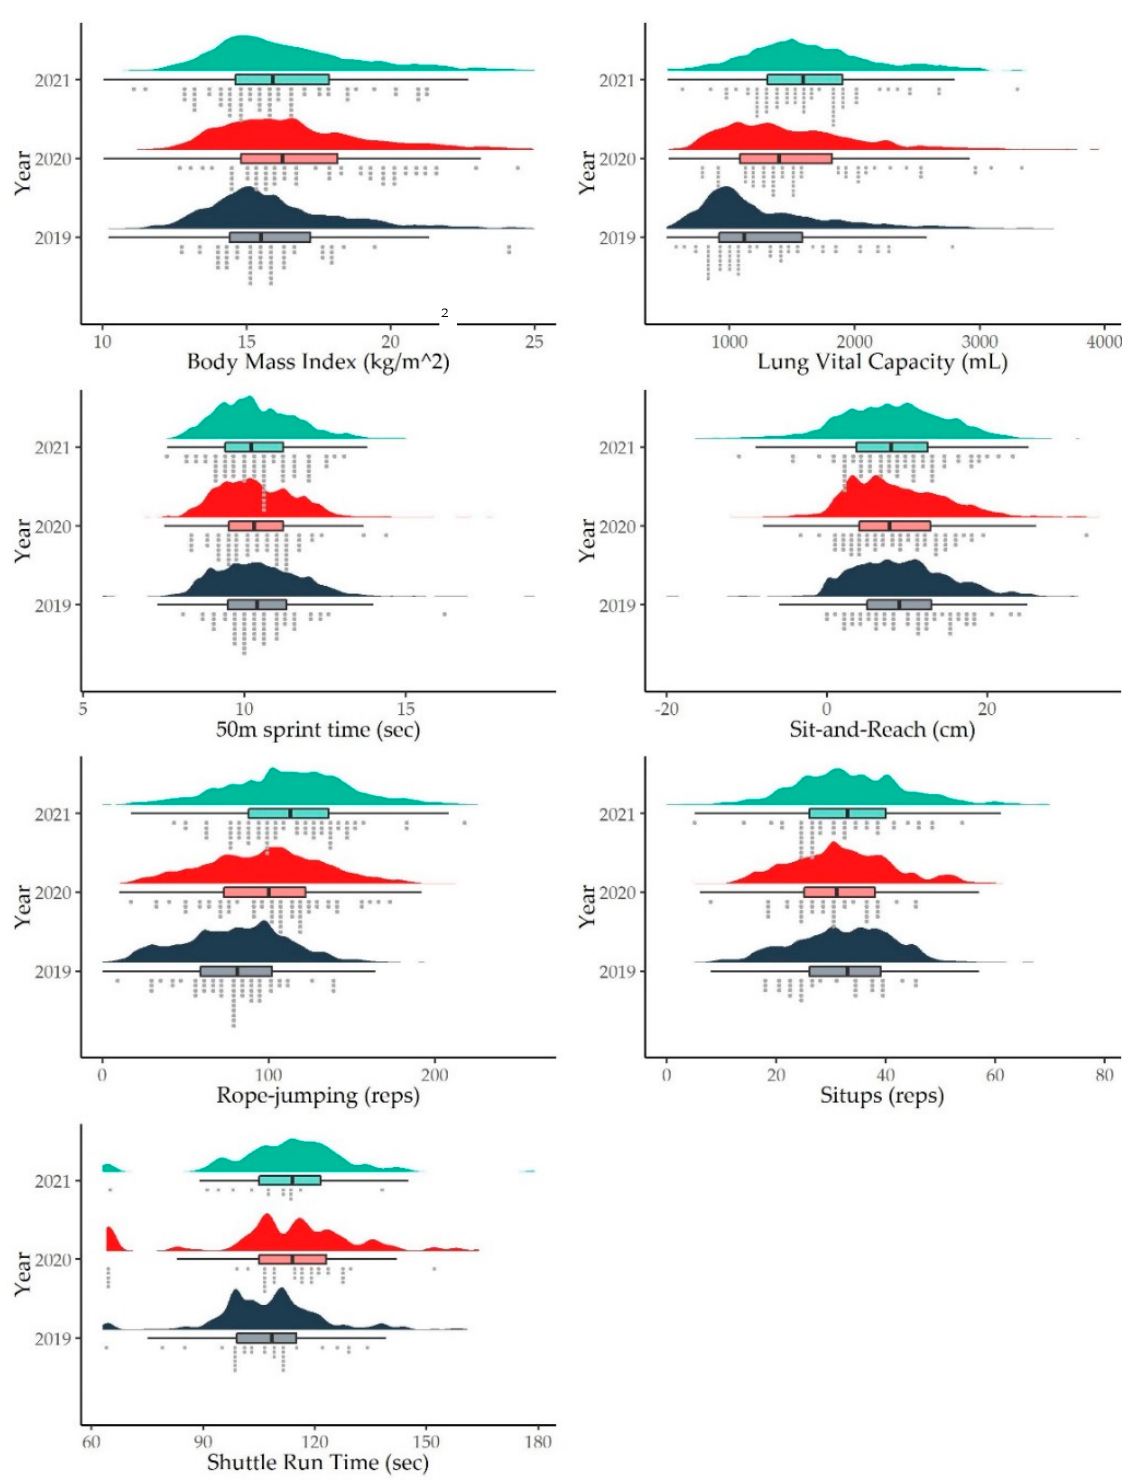
Figure 2. Outcome measures and their distribution for the different years of measurement (purple, 2019; red, 2020; cyan, 2021).